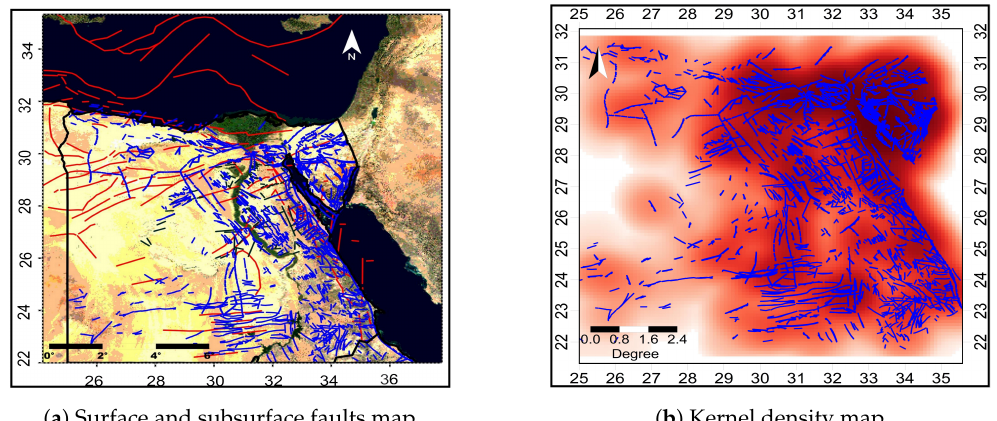
Figure 8. ( a ) Distribution of major surface and subsurface faults. Compiled and redrawn from [14,15,20,39,41,53,54,58–64], ( b ) Kernel density map for all lineaments, surface and subsur- face